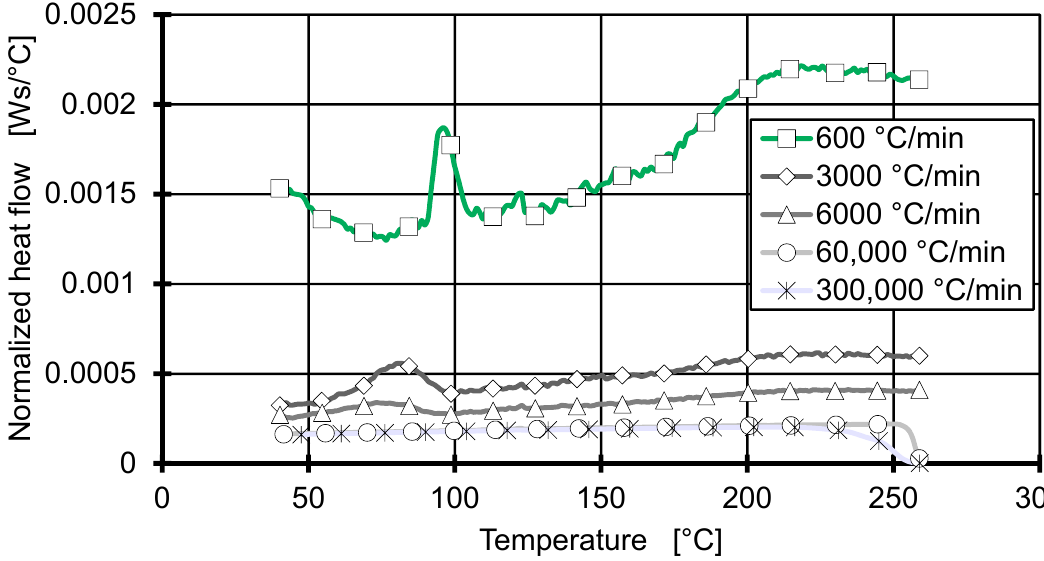
Figure 1. Flash DSC 2+ measurements of isotactic polypropylene at cooling rates from 600 to 300,000 °C/min normalized to their cooling rate.